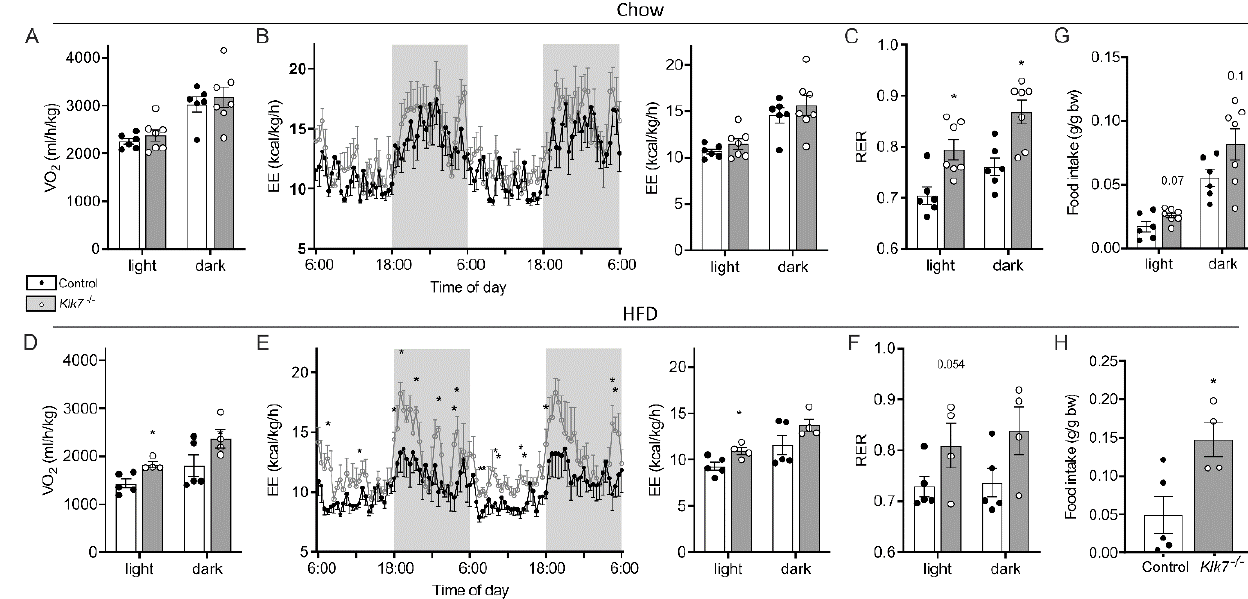
Figure 1. Body weight development and body composition of Klk7 −/− deficient mice under chow and high fat diet. ( A , B ) Body weight gain under chow and HFD for Klk7 −/− ( n = 8/5 chow/HFD) and con- trol mice ( n = 8/9 chow/HFD). Weight gain is significantly reduced for Klk7 −/− mice under both diets. ( C , D ) MRI scans reveal a significant reduction in total fat mass (presented as % of body weight) for Klk7 −/− mice beginning at an age of 10 weeks and independent of the diet. ( E , F ) Determination of relative organ weights show that Klk7 −/− mice under chow diet exhibit decreased eWAT fat mass compared to chow-fed control mice, while HFD-fed Klk7 −/− mice have both reduced eWAT and iWAT fat mass compared to obese controls. Data are presented as means ± SEM; significance was tested by two-way ANOVA with correction for multiple testing (Sidak; A , B ) or multiple t -tests with correction for multiple testing (Holm–Sidak; C – F ); * p < 0.05; ** p < 0.01; *** p < 0.001.